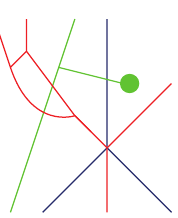
Figure 2: An example of a planar graph in the strip, with colored edges.